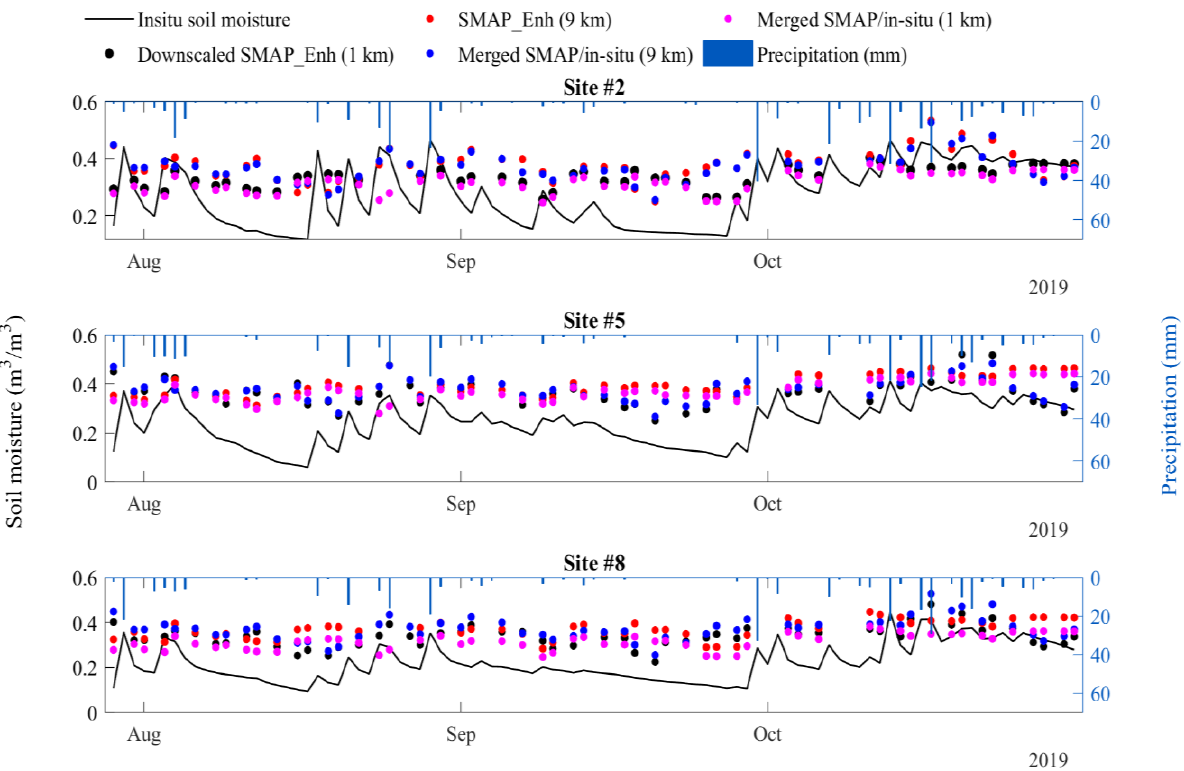
Figure 5. Time series of in-situ soil moisture comparing with SMAP (i.e., downscaled and its original counterparts) and merged SMAP/in-situ soil moisture.